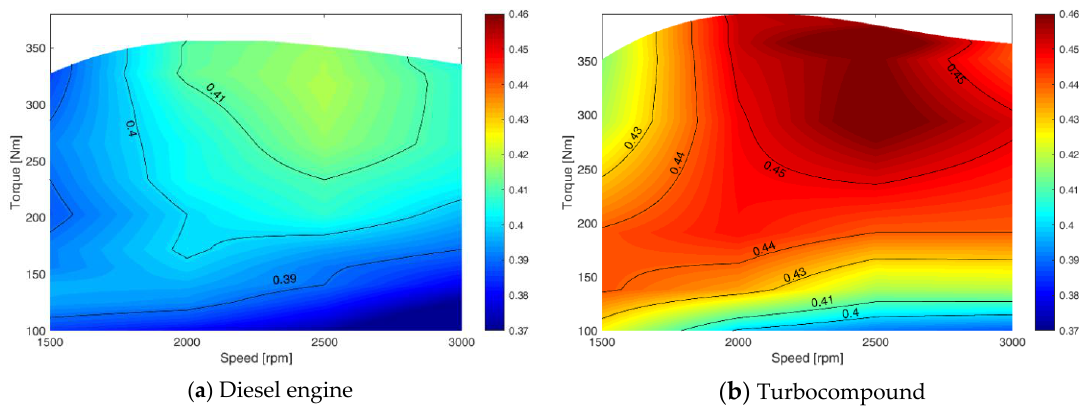
Figure 9. ICE efficiency contour map. Figure 9. ICE e ffi ciency contour map.